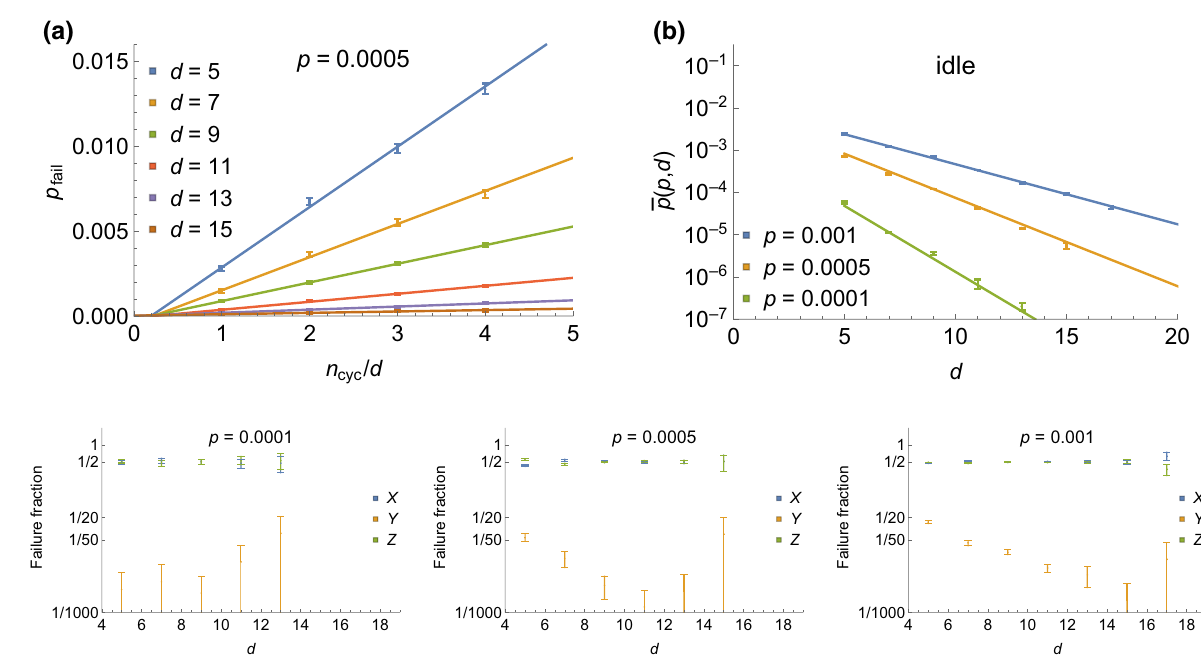
FIG. 17. Analysis of the logical idle operation. (a) The failure probability using the best-performing CNOT schedule as a function of n cyc / d for p = 5 × 10 − 4 . We use the ansatz in Eq. (13) to find the logical failure rate p ( p , d ) . We observe that QEC equilibration occurs by the d th cycle; see Appendix B for additional data. Not discarding the initial equilibration period would result in an underestimate of the failure probability. (b) For each value of p , we use the ansatz in Eq. (7) to extract the parameters for p panels) The fraction of overall failures corresponding to different logical Pauli errors. The points whose data range falls below the horizontal axis correspond to no observed